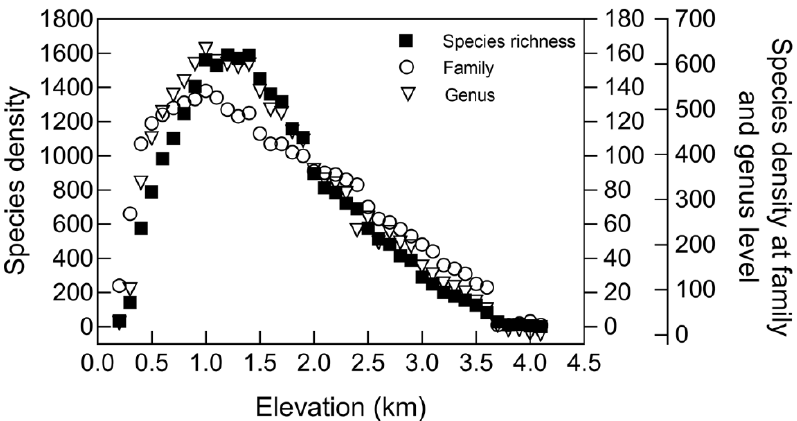
Figure 1. The altitudinal patterns of richness in Qinling Mountains at species (square), genus (inverted triangle), and family (circle) levels.